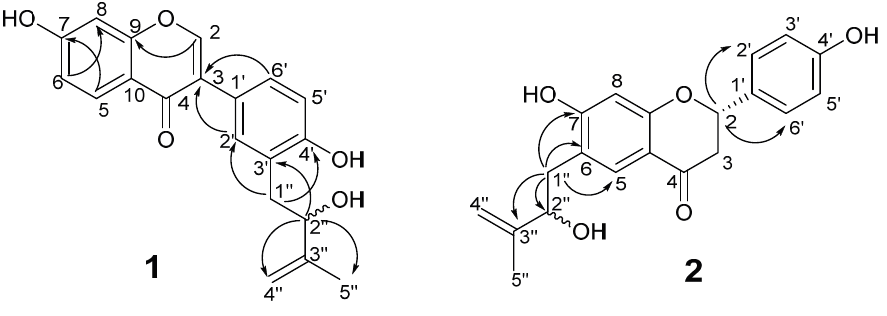
Figure 2. HMBC correlations of compounds 1 and 2